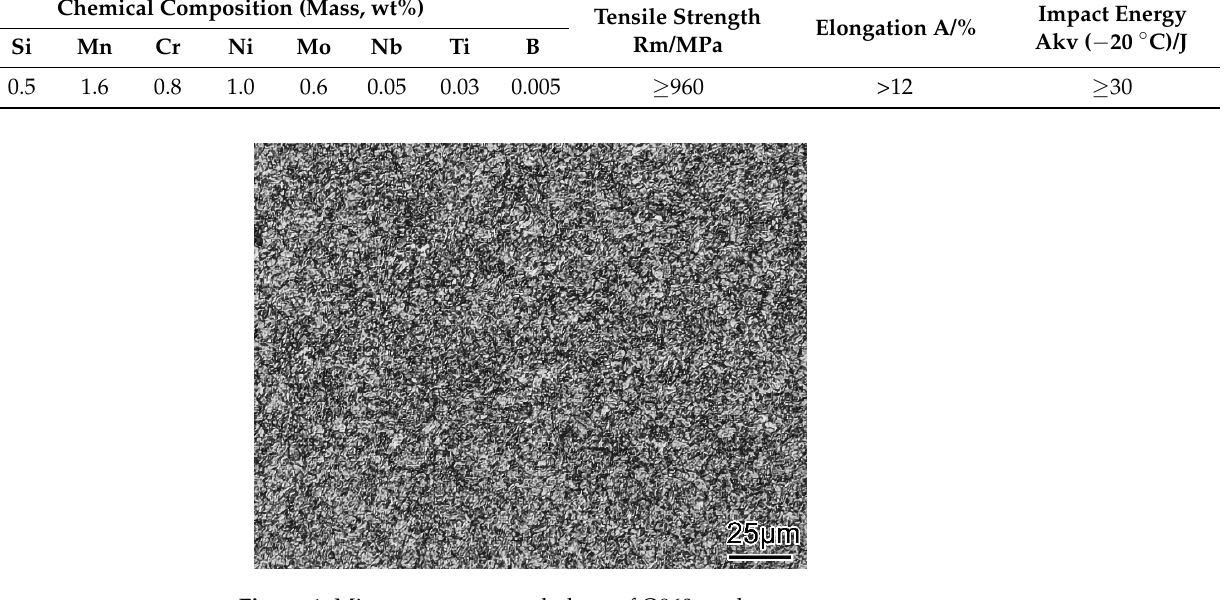
Figure 1. Microstructure morphology of Q960 steel. Table 1. Chemical composition and mechanical properties of Q960 steel.